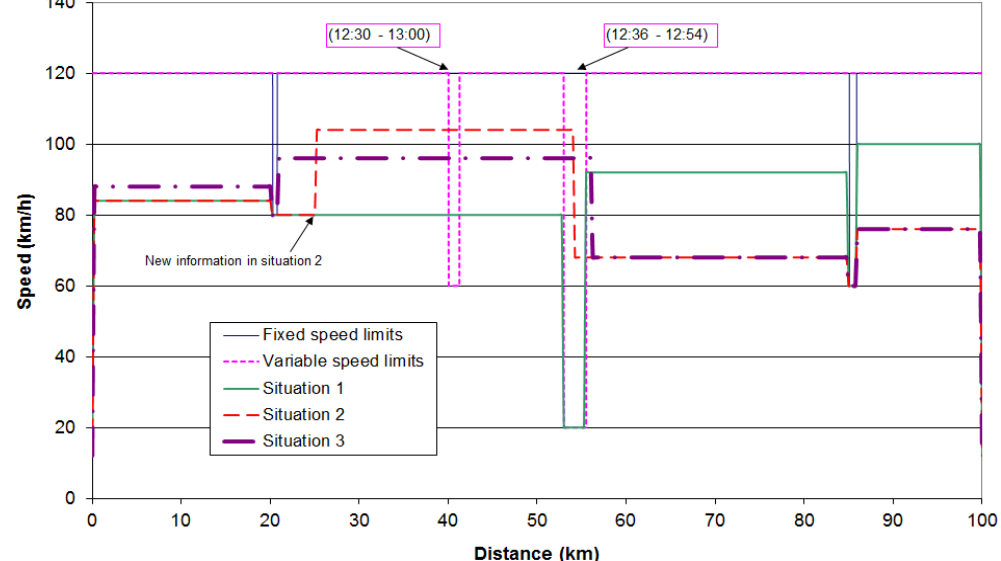
Figure 6. Constant speed profile (unexpected speed